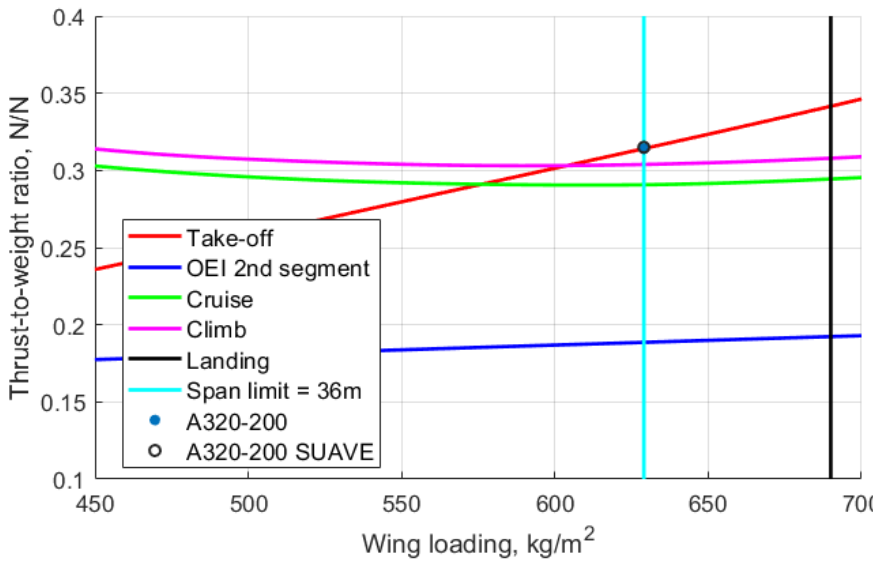
Figure 5. Constraint diagram and comparison against A320-200 reference data.